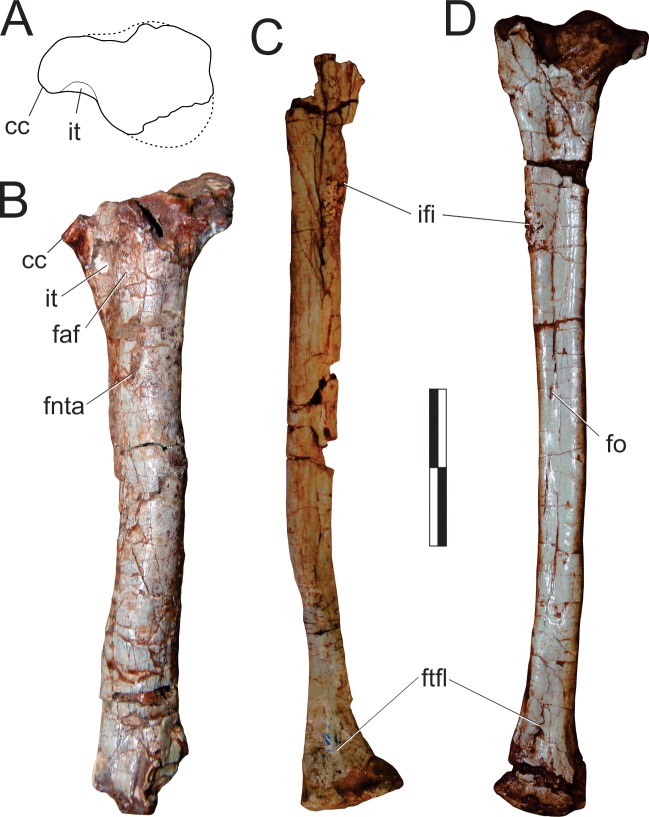
Pampadromaeus barberenai (ULBRA-PVT016), tibia and fibula.Drawing (A) and photographs (B-D) of the epipodium. Left tibia in (A) proximal and (B) lateral views. Medial view of the (C) left and (D) right fibulae. Abbreviations: cc, cnemial crest; faf, fibular articular facet; fnta, foramen for the nutritive tibial artery; fo, foramen; ftfl, facet for the tibiofibular ligament; ifi, m. iliofibularis insertion; it, insisura tibialis. Scale bar = 3 cm.